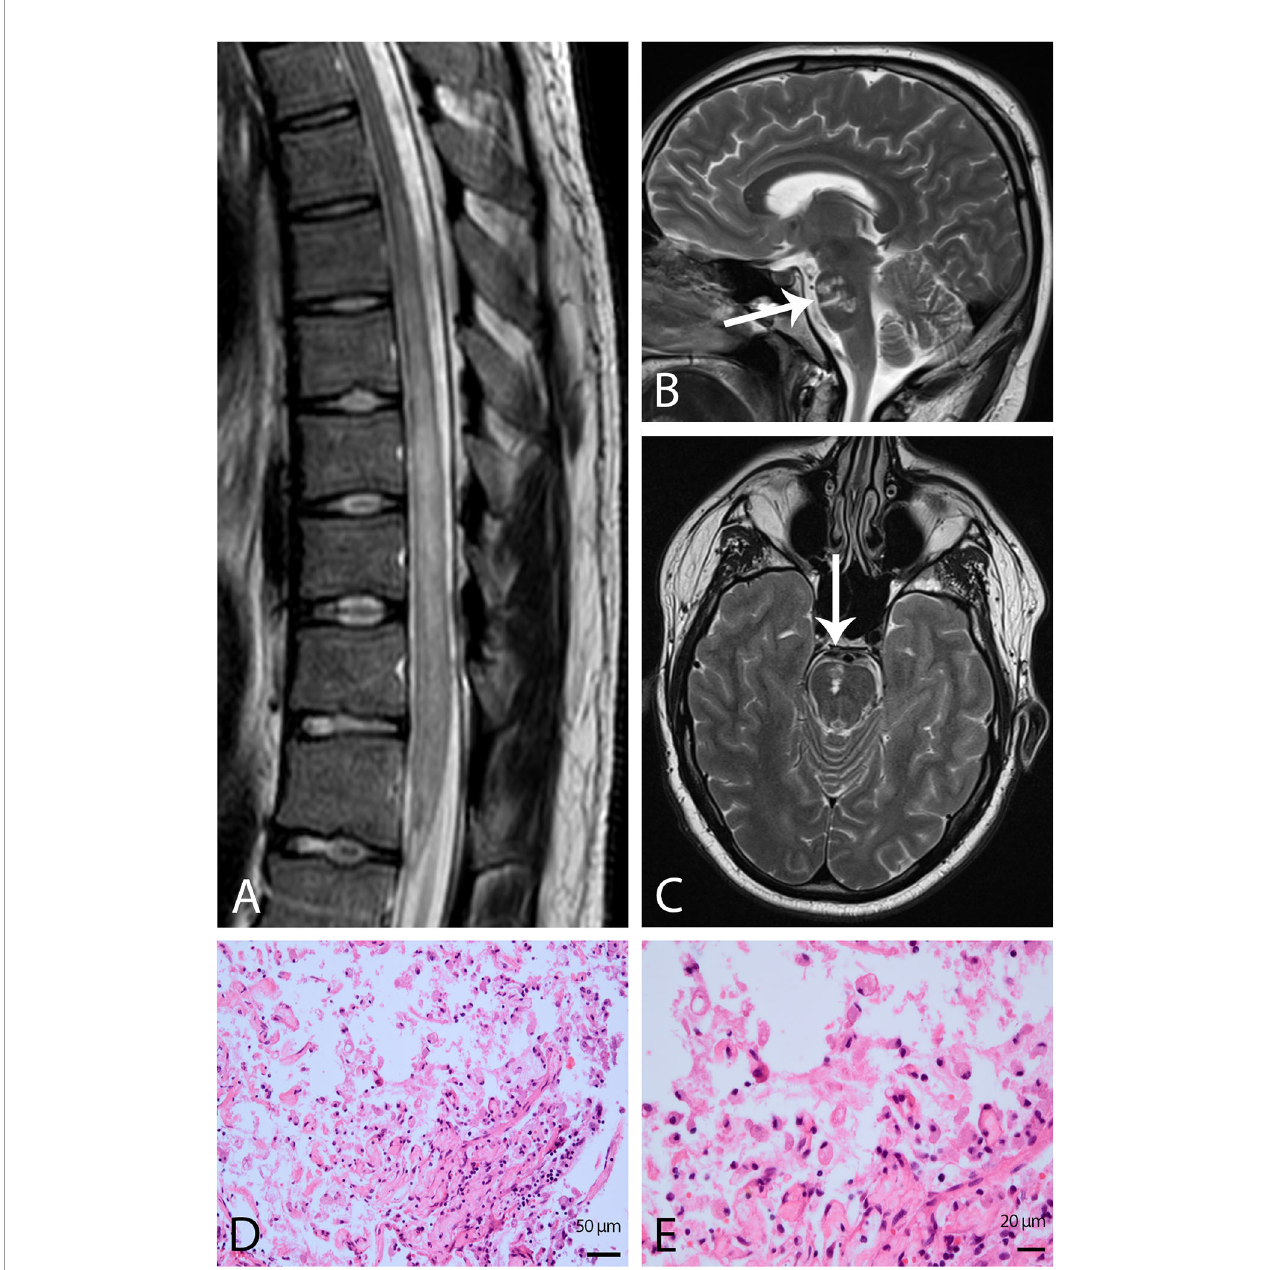
FIGURE 1 | Findings from MRI and histological examination of spinal cord ischemia. (A) Sagittal T2-weighted image of the thoracic spinal cord demonstrating a pronounced hyperintensity from the seventh to the twelfth thoracic vertebra. Sagittal (B) and axial (C) T2-weighted turbo spin-echo images of the brain displaying right-sided pontine infarction which is marked by a white arrow. Hematoxylin and eosin (H&E) staining of myelon biopsy displaying necrotic central nervous system tissue with macrophages. Original magni fi cation 20x (D) and 40x (E)